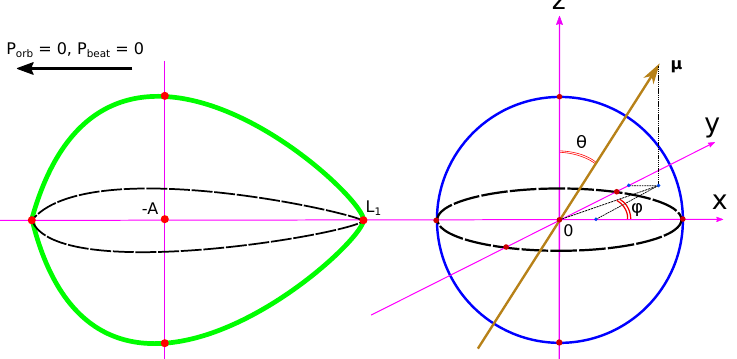
Figure 1. The Cartesian coordinate system used in the model. The position of the accretor and the donor, the magnetic axis and the reference direction of the orbital phase, as well as the phases of the beat period for the asynchronous system are